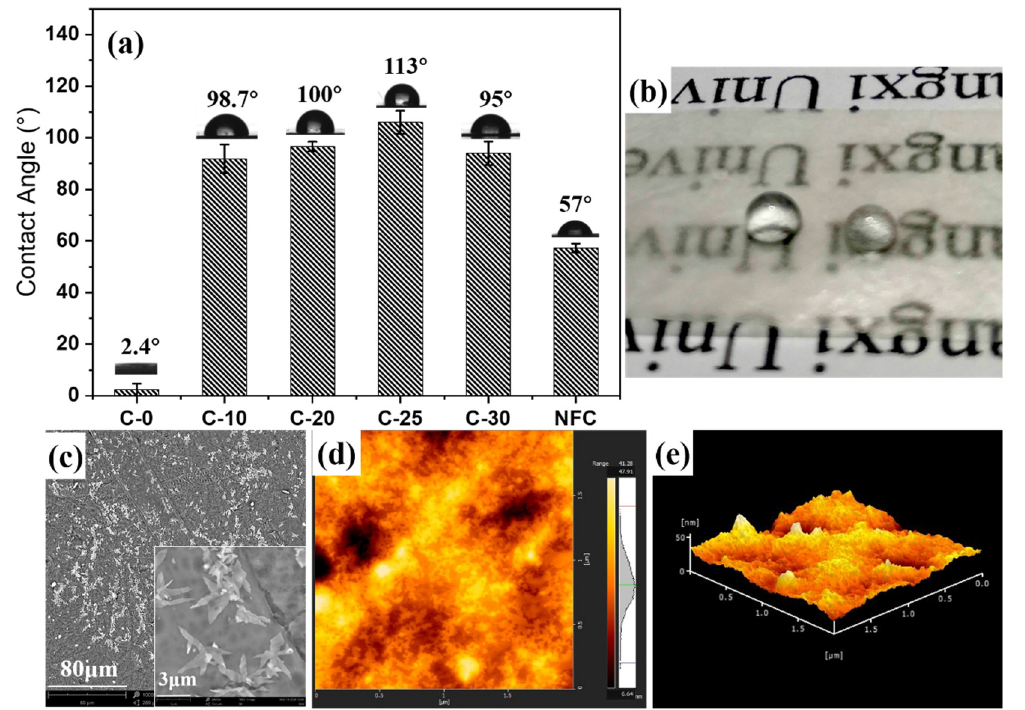
Figure 6. ( a ) Contact angle of nano/microfibrils films, ( b ) digital photographs of C-25 film hydro- phobicity, ( c ) SEM micrographs of the C-25 film, ( d ) AFM surface topography (2 × 2 μ m 2 ), and ( e ) 3D image of the C-25